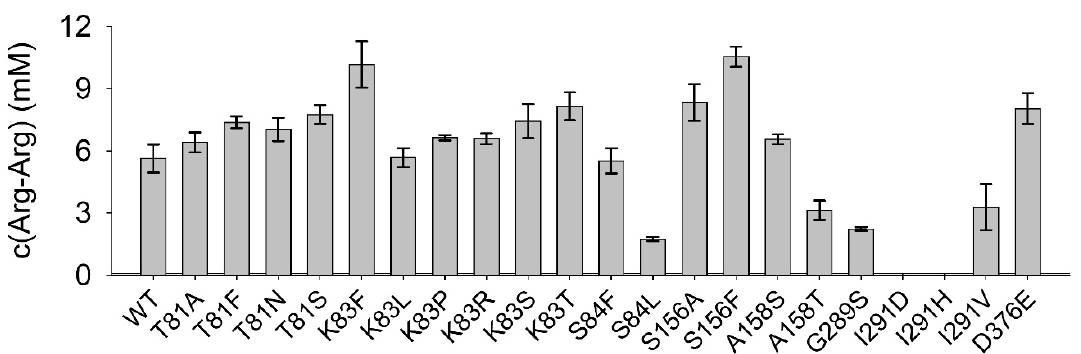
Figure 4. Formation of Arg-Arg by the RizA variants. 60 mM arginine and 20 h reaction time at 25 °C. Reactions were set up in triplicates and data is presented as mean ± standard deviation.